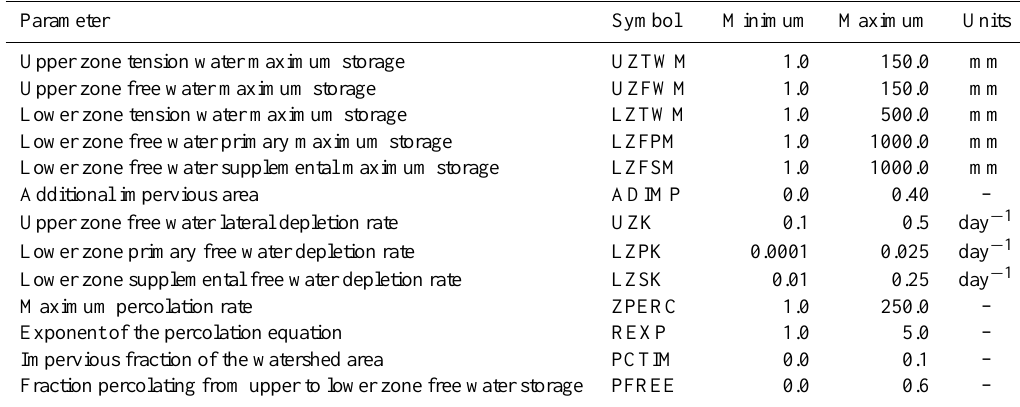
Table 2. Description of the SAC-SMA model parameters and their (uniform) prior uncertainty ranges.